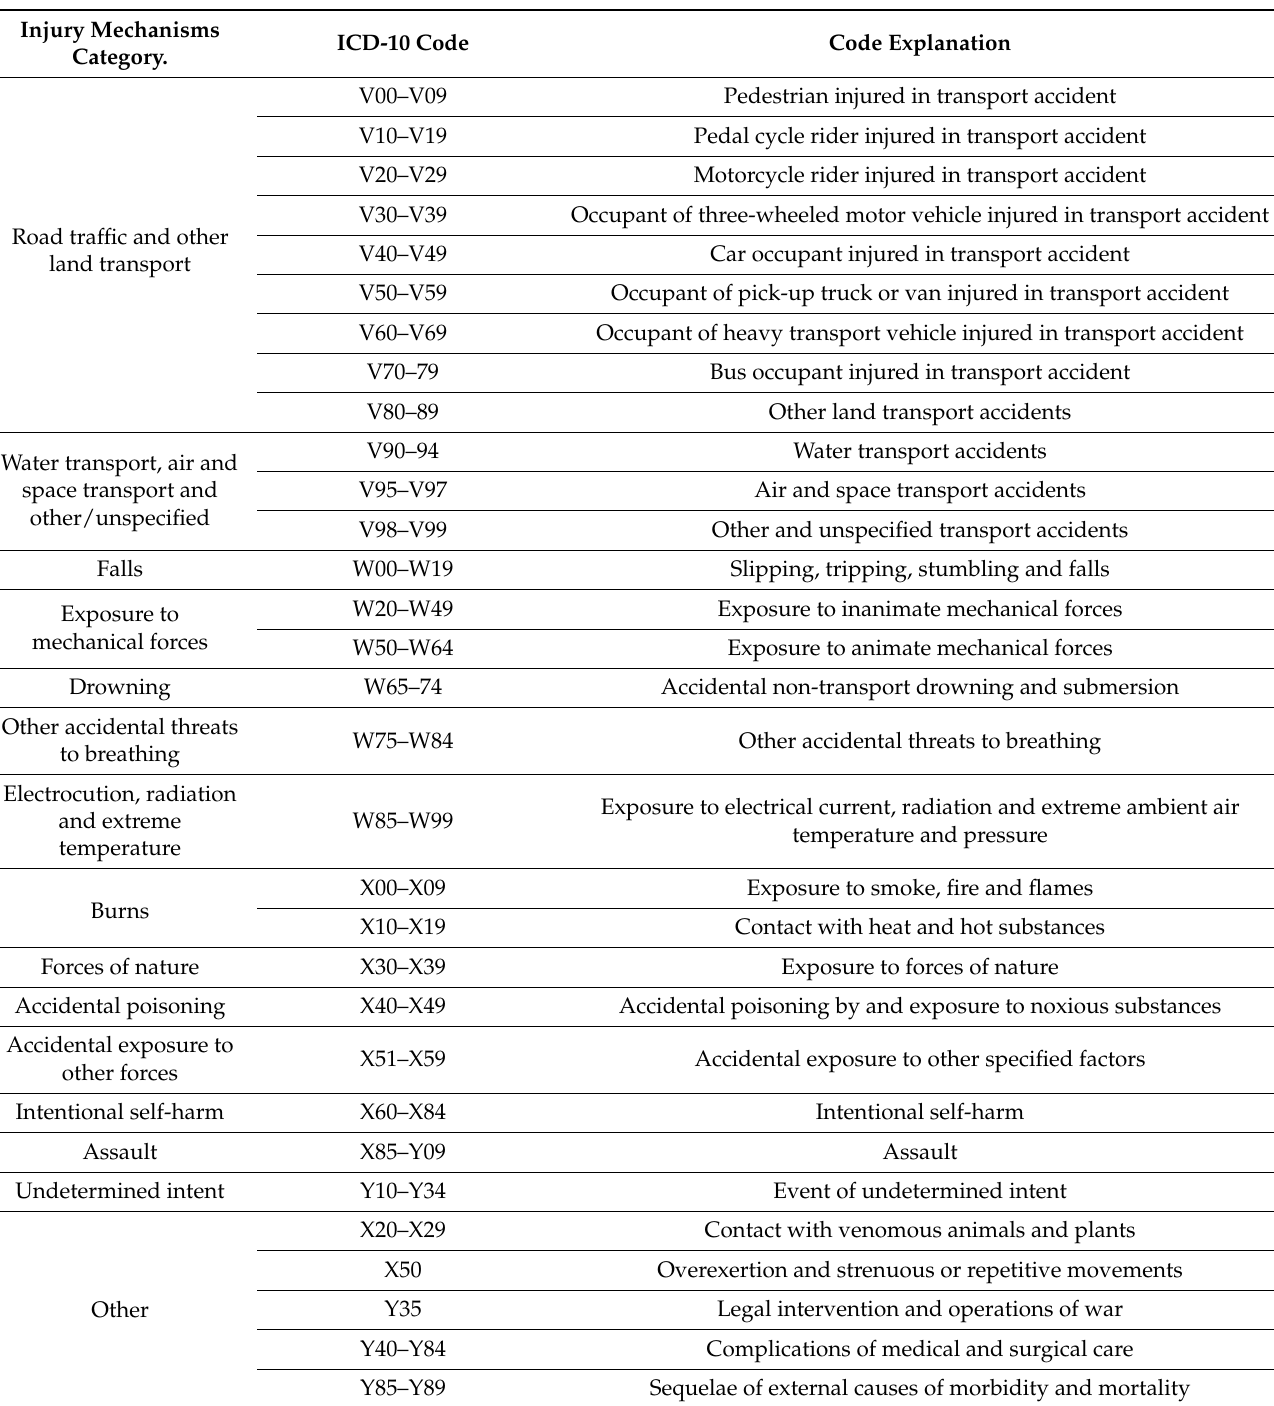
Table 1. Injury categories used in study and associated International Classification of Diseases (ICD)-10 codes. Injury Mechanisms